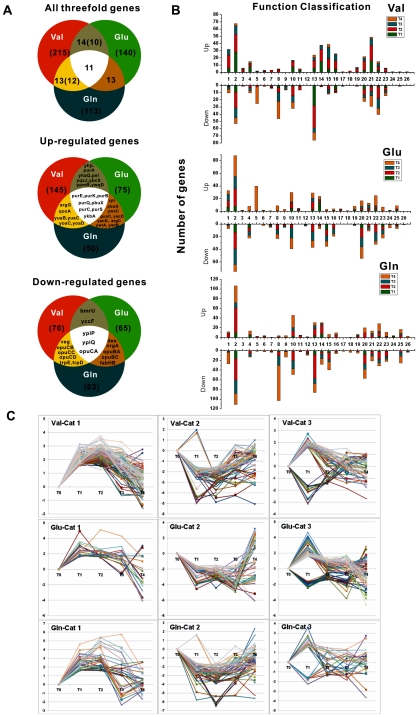
Rapidly AA-responsive Genes.(A) Venn diagrams about the number of rapidly Val-, Glu-, and Gln-responding genes: all three-fold responsive genes at 5 min; the three-fold induced genes at 5 min; the three-fold repressed genes at 5 min; There are four genes (yhgD, pel, cydA, and cydB) showing converse expression between Val and Glu; one gene ilvB, showing converse expression between Val and Gln. (B) Classification of all amino acid-responsive genes: All valine-(Val), glutamate-(Glu), and glutamine-(Gln) responsive genes with known-function were classified according Subtilist Database (http://genolist.pasteur.fr/SubtiList/). 1, Cell wall; 2, Transport/binding proteins and lipoproteins; 3, Sensors (signal transduction); 4, Membrane bioenergetics; 5, Mobility and chemotaxis; 6, Protein secretion; 7, Cell division; 8, Sporulation; 9, Germination; 10, Specific pathways; 11, Main glycolytic pathways; 12, TCA cycle; 13, Metabolism of amino acids and related molecules; 14, Metabolism of nucleotides and nucleic acids; 15 Metabolism of lipids; 16, Metabolism of coenzymes and prosthetic groups; 17, Metabolism of phosphate; 18, Metabolism of sulfur; 19, DNA recombination; 20, RNA synthesis; 21, Protein synthesis; 22, Adaptation to atypical conditions; 23, Detoxification; 24, Antibiotic production; 25, Phage-related functions; 26, Transposon and IS. (C) Three expression categories of rapidly responsive genes: In category 2 of valine (Val-Cat 2), cydBC genes, encoding cytochrome bd ubiquinol oxidase and ABC membrane transporter, were upregulated at 5 min, whereas downregulated after 30 min.